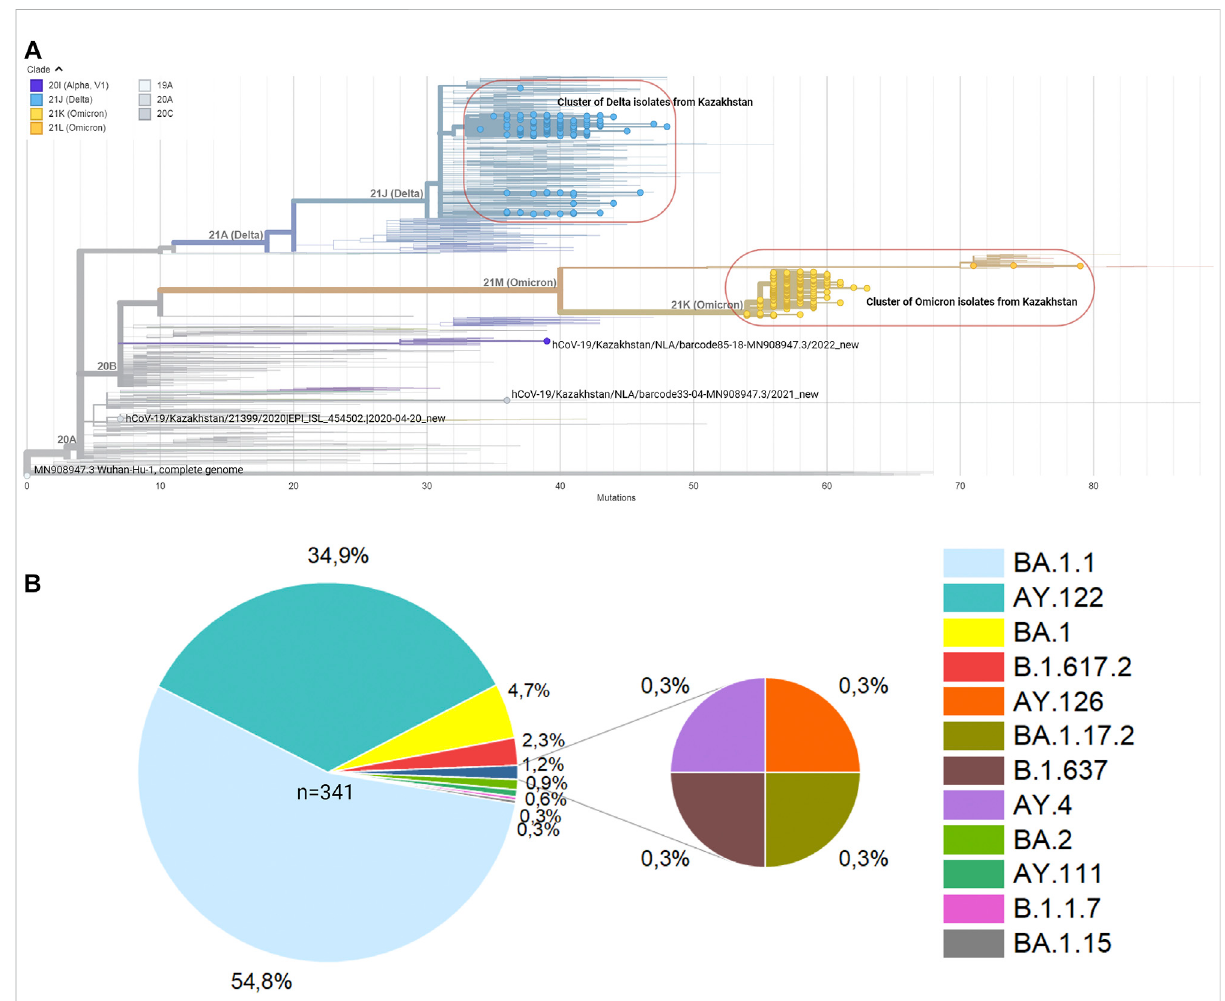
FIGURE 2 Phylogenetic distributionofsequencedSARS-CoV-2genomes. (A) AphylogenetictreeisgeneratedbyNextstrain. (B). Theproportionofclades and Pangolin lineages of n = 341 sequenced SARS-CoV-2